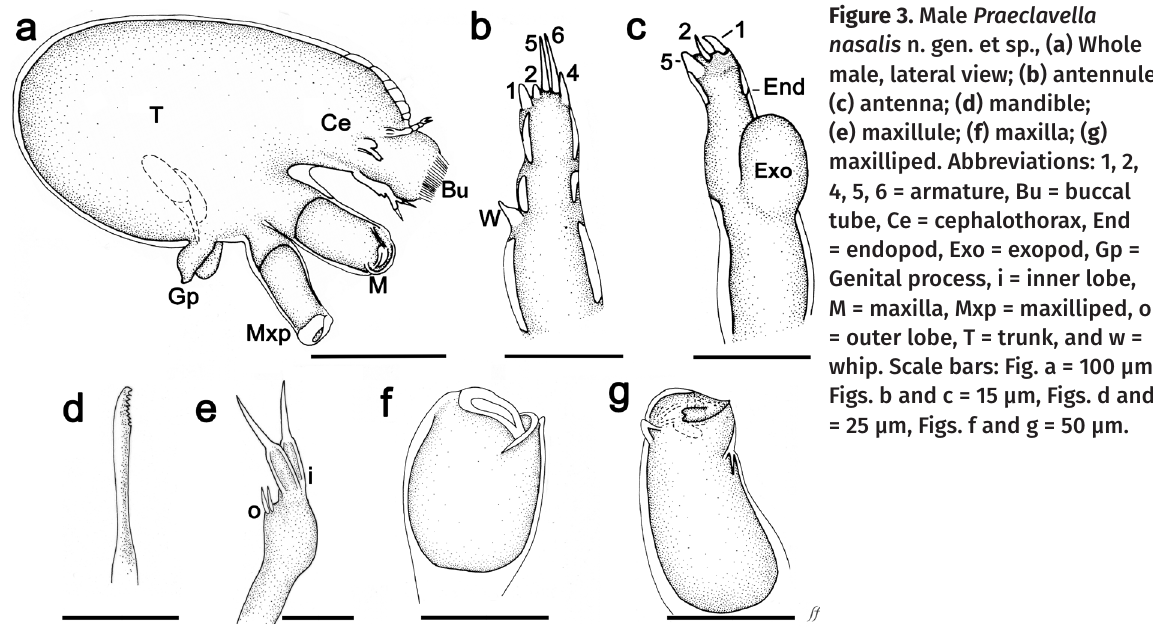
Figure 3. Male Praeclavella nasalis n. gen. et sp., ( a ) Whole male, lateral view; ( b ) antennule; ( c ) antenna; ( d ) mandible; ( e ) maxillule; ( f ) maxilla; ( g ) maxilliped. Abbreviations: 1, 2, 4, 5, 6 = armature, Bu = buccal tube, Ce = cephalothorax, End = endopod, Exo = exopod, Gp = Genital process, i = inner lobe, M = maxilla, Mxp = maxilliped, o = outer lobe, T = trunk, and w = whip. Scale bars: Fig. a = 100 µm, Figs. b and c = 15 µm, Figs. d and e = 25 µm, Figs. f and g = 50